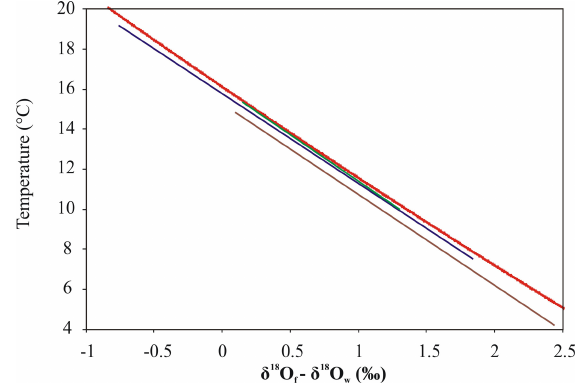
Fig. 3. Comparison of our experimental calibration equation with the theoretical equation for equilibrium calcite of Kim and O’Neil (1997). The brown, blue and green lines represent the calibration equations of cultured B. marginata from ≤ 150, 150–200 and 200– 250µm size fractions, respectively. The quadratic equation derived from Kim and O’Neil (1997) relationship is represented by the red